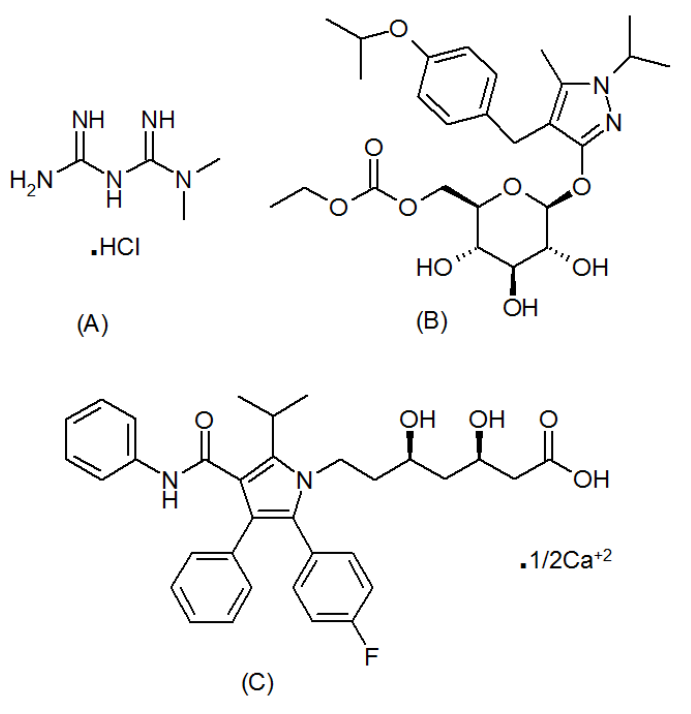
Figure 1. Chemical structure of metformin HCl ( A ), remogliflozin etabonate ( B ), and atorvastatin ( C ).